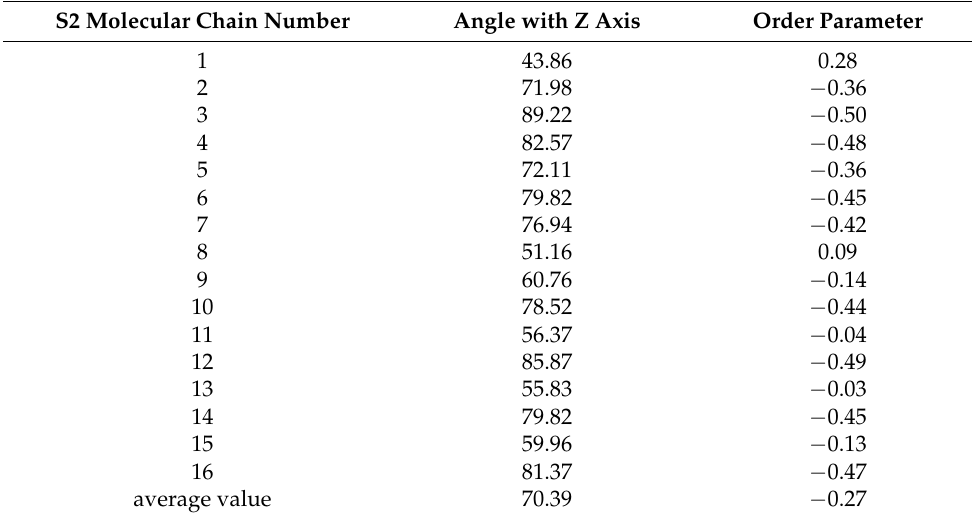
Table 2. The angle between the S2 molecule and the Z axis and order parameters.